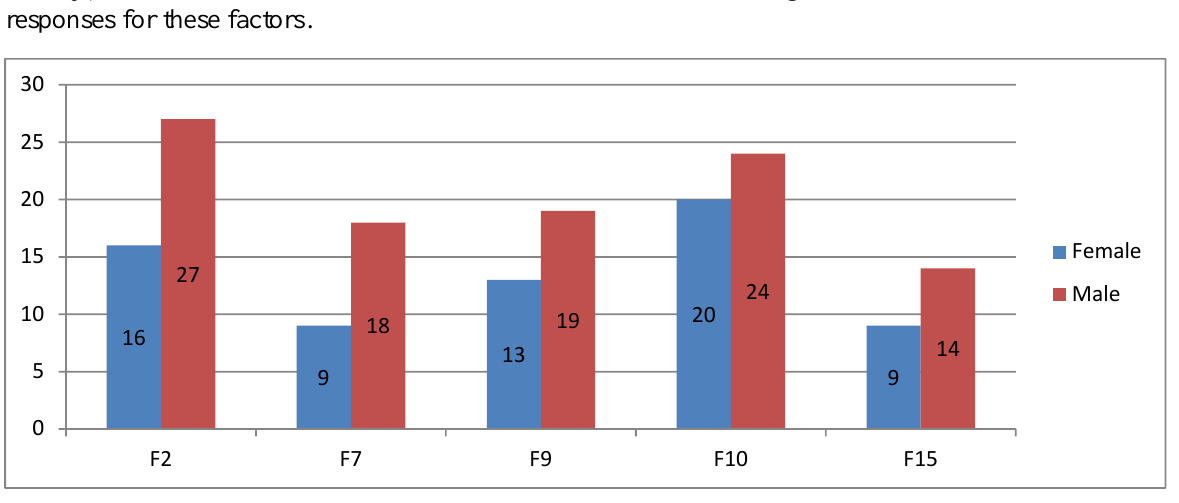
Fig. 3. The frequency of answers to technical based